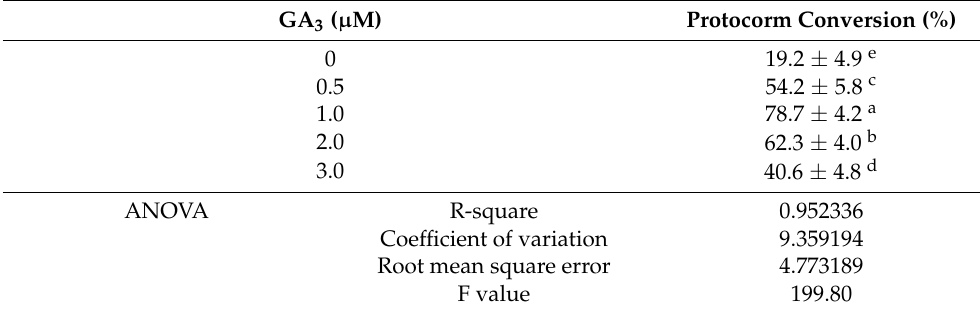
Table 6. Effect of various concentrations of GA 3 on the conversion (%) of SLC